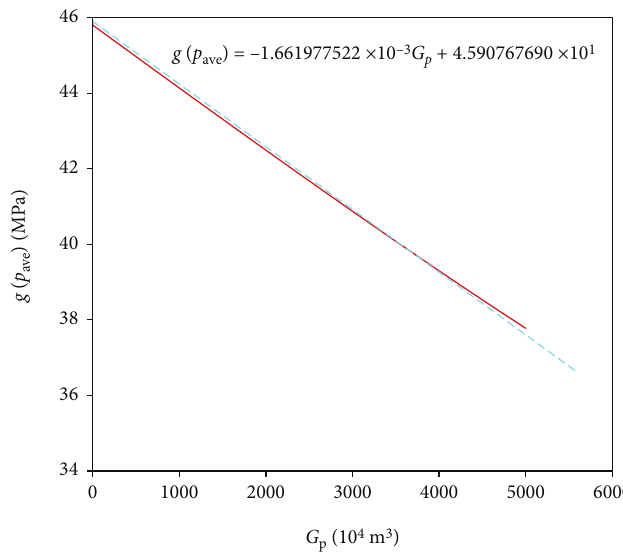
Þ to G for the gas well producing at a constant production p ave